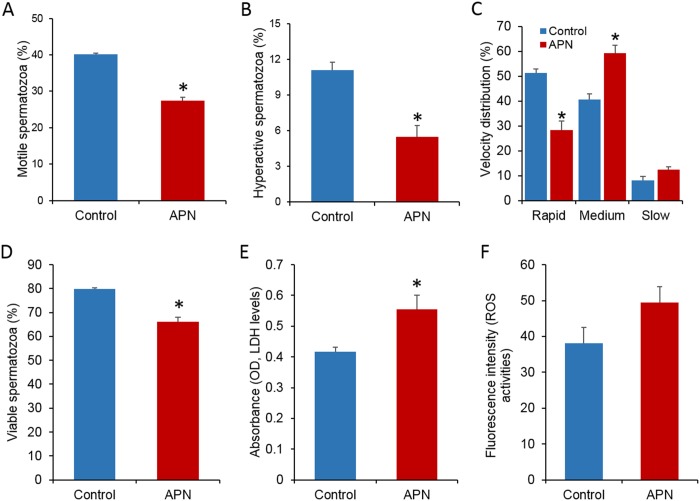
Effects of addition of recombinant APN (20 ng/mL) on motility, hyperactive motility, viability, LDH, and intracellular ROS levels in mice spermatozoa.(A) Sperm motility (%) (P = 0.00001). (B) Hyperactive motility (HYP%) (P = 0.003). Data represent the mean ± SEM of four replicates. (C) The percentage of rapid- (P = 0.00001), medium- (P = 0.001), and slow-speed (P = 0.053) spermatozoa (D) The percentage of viable spermatozoa (P = 0.002). (E) LDH levels (P = 0.045). (F) Intracellular ROS levels (P = 0.142). Data represent the mean ± SEM of three replicates. *P < 0.05, calculated using two-tailed Student’s t-test.